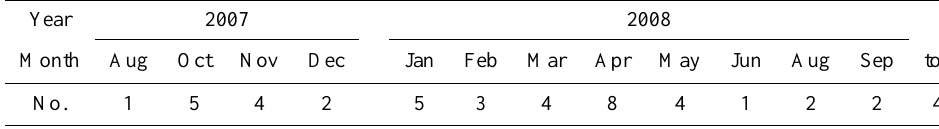
Table 1. The number of sample sets of PM 10 , PM 2 . 5 , and PM 1 . 0 taken from August 2007 to September 2008.